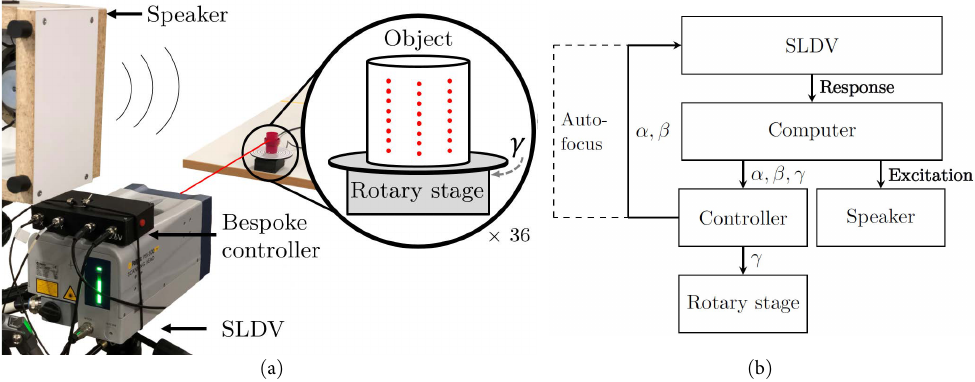
Figure 2. Experimental arrangement: ( a ) physical set-up with the sound source, measurement beam, and SLDV measurement grid highlighted, ( b ) block diagram where solid and dashed lines are wired and wireless connections, respectively, α and β are the scanning mirror angle command signals, and γ is the rotary stage angle command